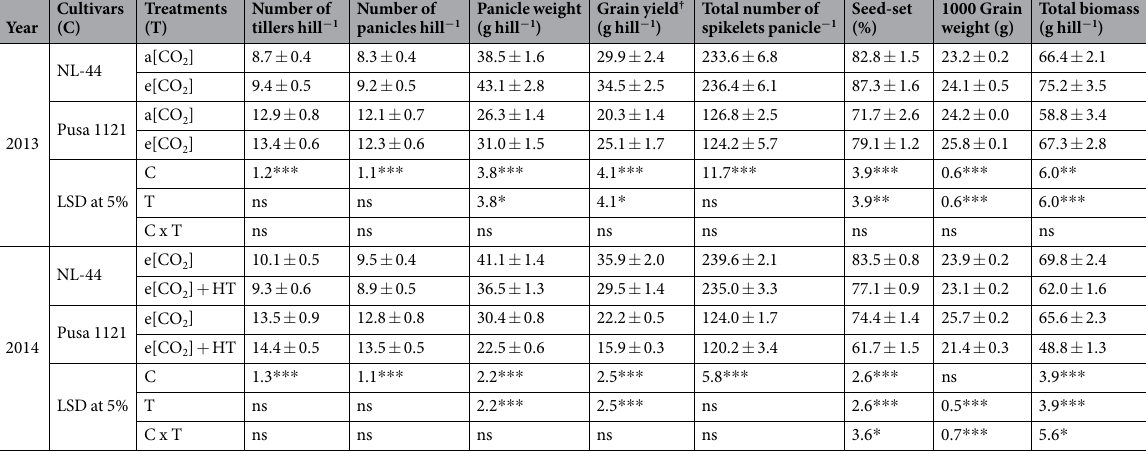
Table 2. Grain yield and yield parameters in rice cultivars NL-44 and Pusa 1121 exposed to ambient and elevated [CO 2 ] during 2013 and elevated [CO 2 ] and elevated [CO 2 ] + HT interaction during 2014. All the parameters were obtained at physiological maturity. Significance level: * P < 0.05 , ** P < 0.01 , *** P < 0.001 , ns = non significant [LSD = least significant difference; HT = heat stress; a[CO 2 ] = ambient CO 2 ; e[CO 2 ] = elevated CO 2 ]. † Chaturvedi et al . 2017-Published grain yield data is used for associating the response mechanisms to the agronomic